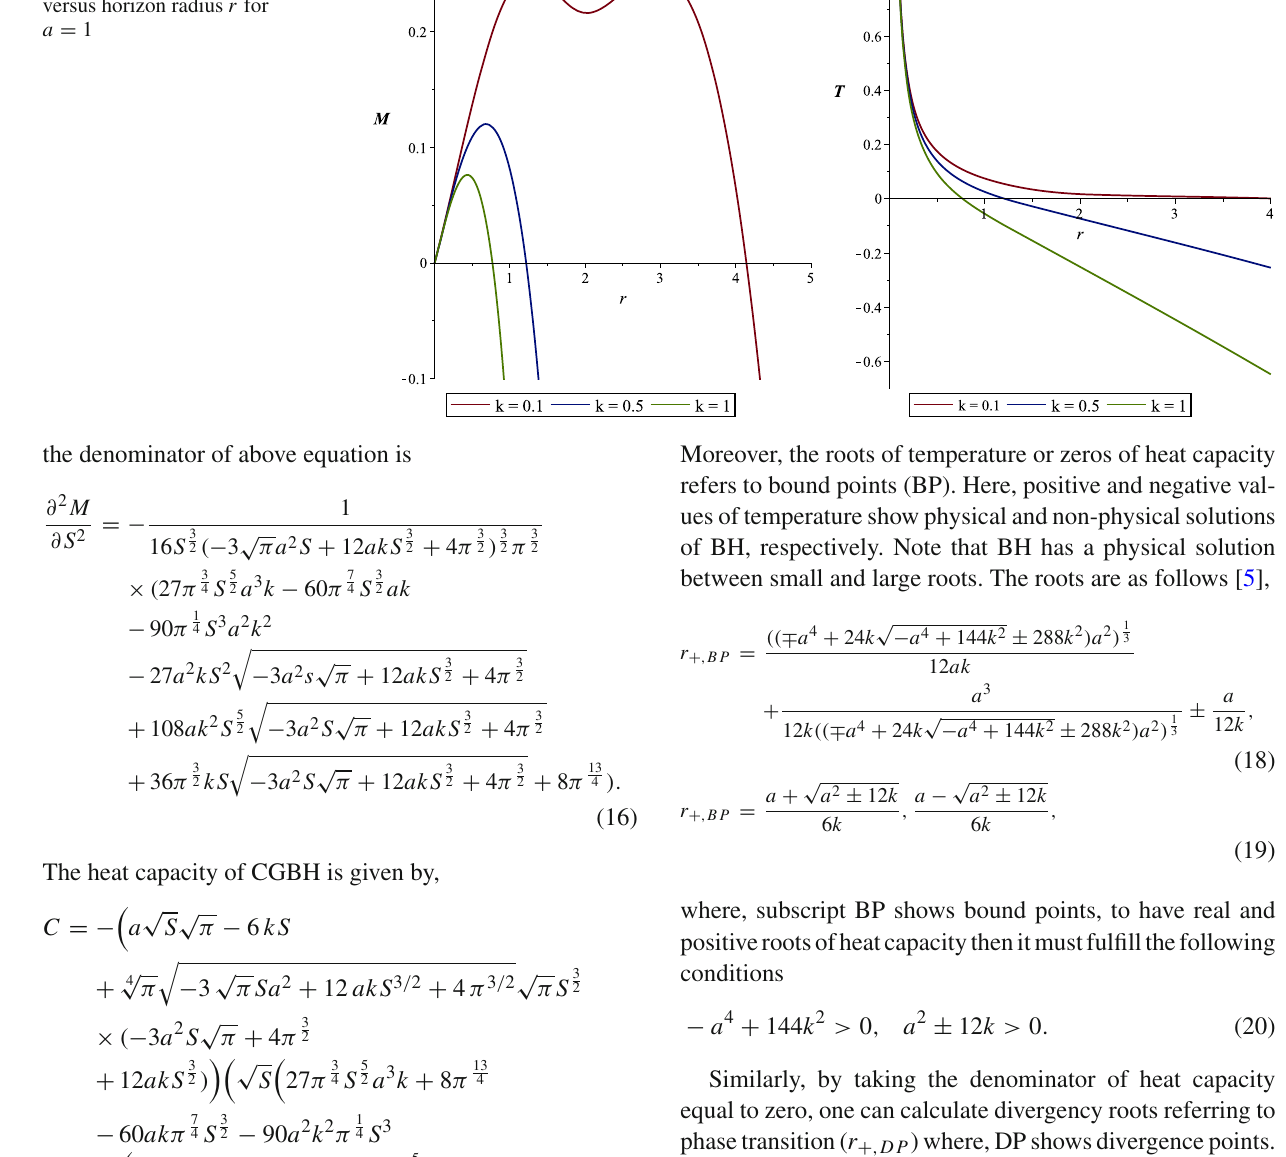
Fig. 1 Mass and temperature versus horizon radius r for a =